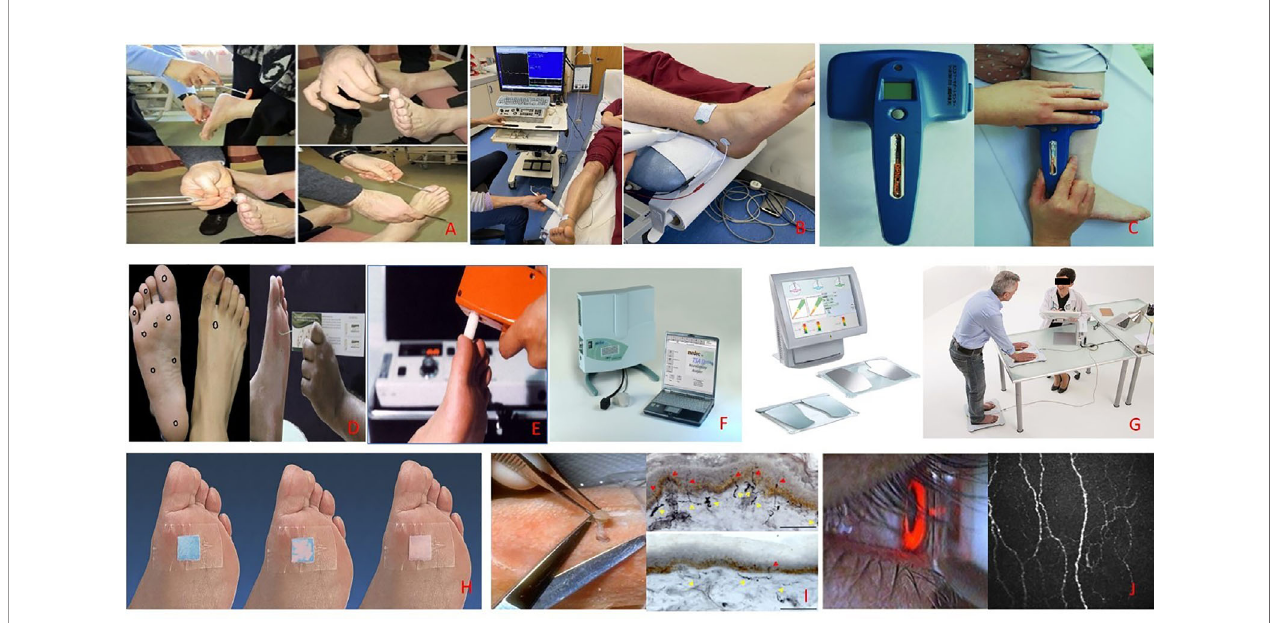
FIGURE 1 | Examples of nine different tests for diabetic peripheral neuropathy (DPN), (A) Physical examination and Neuropathy disability score (NDS), (B) Nerve Conduction studies being performed on the lower leg, (C) DPNcheck device to test sural nerve conduction performed on the lower leg, (D) Mono fi lament screening test sights and procedure, (E) Vibration perception threshold testing, (F) Medoc TSAII quantitative sensory testing device for thermal perception threshold, (G) Sudoscan equipment. Hand and feet sensor plates with displaying test results, (H) Neuropad test demonstrated original blue color, (I) A punch skin biopsy to collect samples needed for IENFD measurement, (J) An image of the corneal sub-basal nerves using corneal confocal microscopy and the CCM probe positioning during corneal